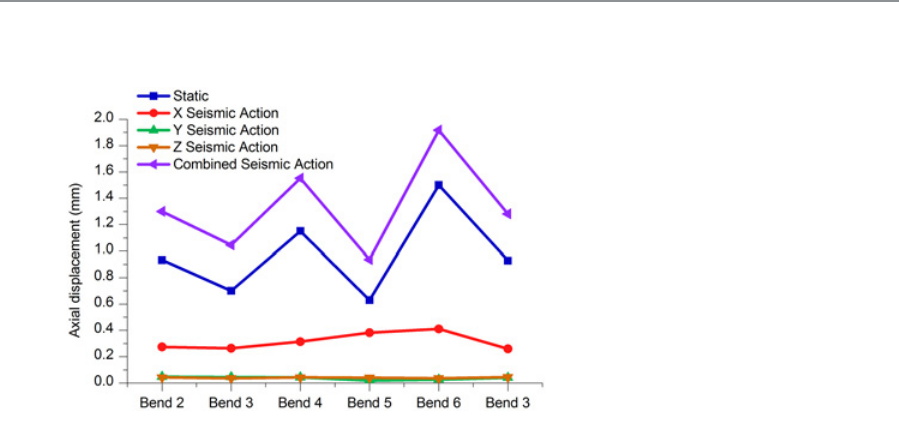
Fig 12. Axial Displacement of each bend under different working conditions.